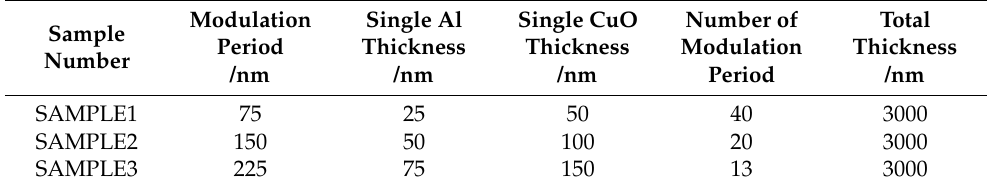
Table 3. Sample parameters of nano Al /CuO energetic composite films with different modula- tion